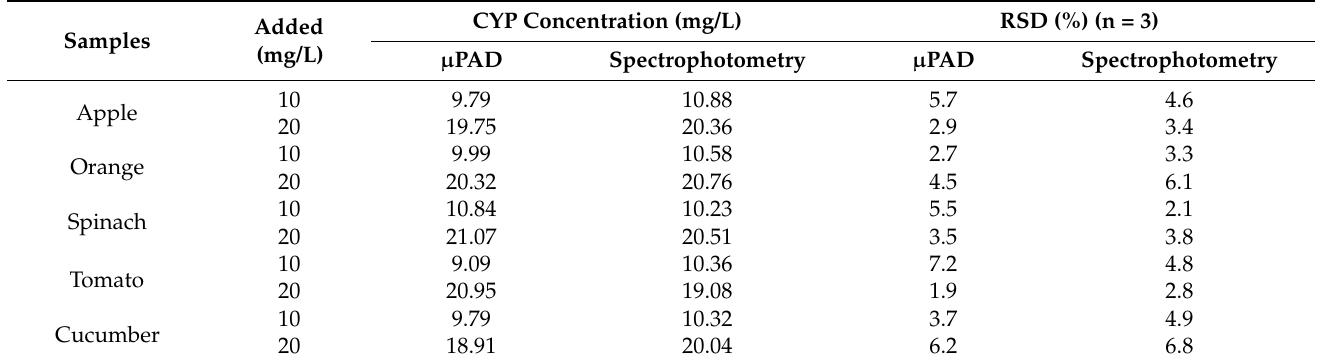
The detection of CYP in five fruit and vegetable samples by pSBMA- µ PAD and UV–visible spectrophotometry.